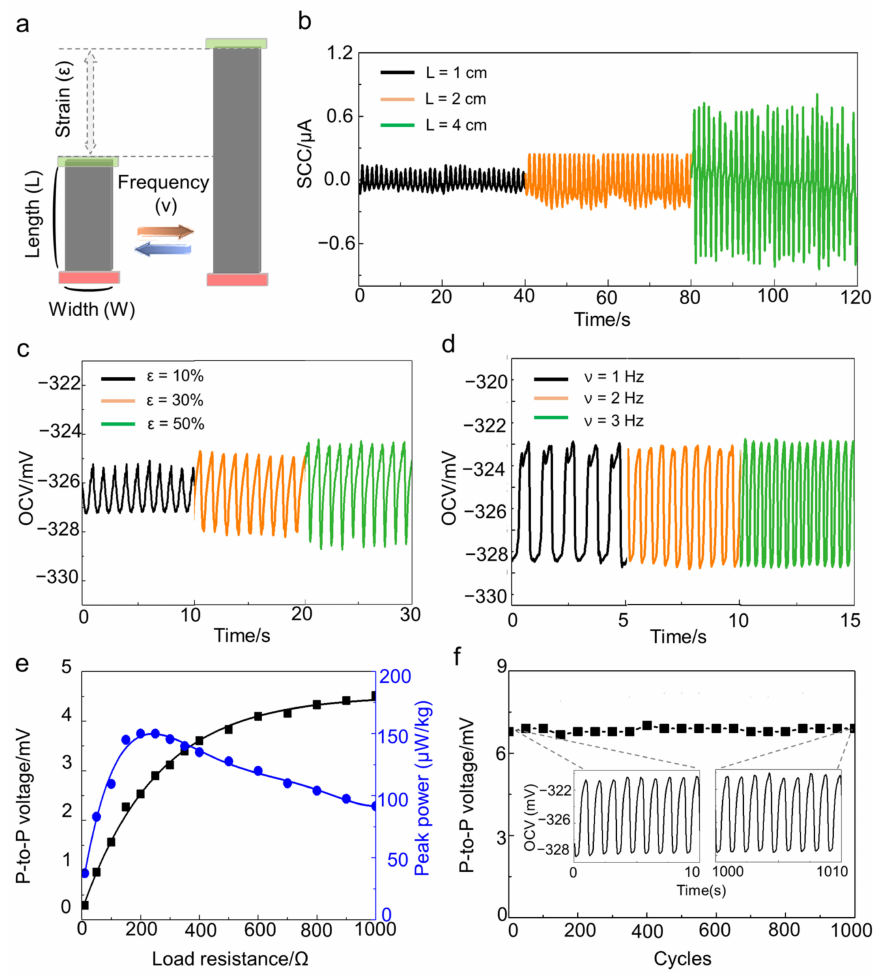
Figure 3. The characterization of the stretchy electrochemical harvester in slow dynamic movement with various conditions. ( a ) The schematic illustration of the harvester with various experimental conditions; ( b ) The short-circuit current output under only length increment from 1 cm to 4 cm at a constant width of 0.5 cm; The open-circuit voltage ( c ) with various applied strains from 10% to 50% during the 1-Hz sinusoidal stretch and ( d ) with various frequencies from 1 Hz to 3 Hz at a strain of 50% in saline; ( e ) The peak-to-peak voltage and peak power with external load resistance; ( f ) The stability of open-circuit voltage output during 1000 cycles in saline, (inset) the open-circuit voltage after first cycles, and 1000